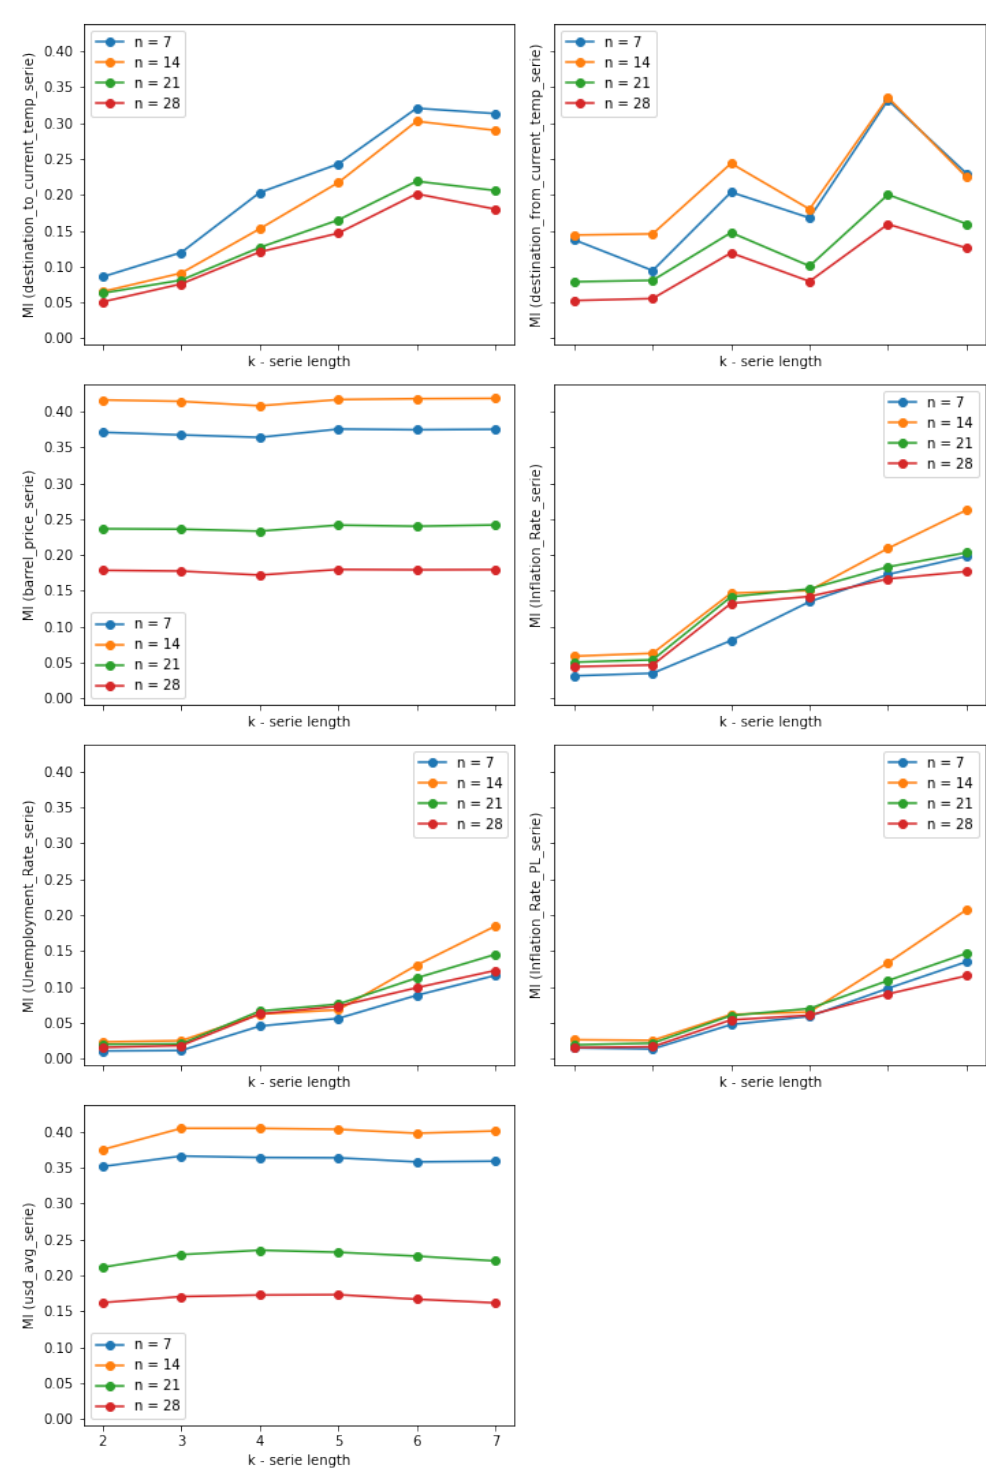
Figure 3. Mutual information values obtained for time varying features for different values of series